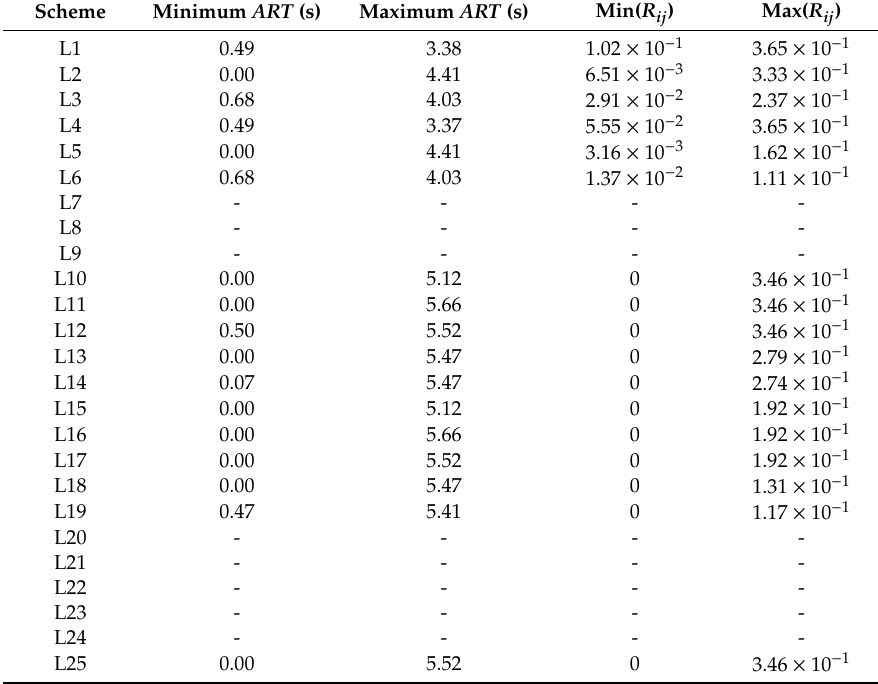
Table 3. Results of the risk analyses: focus on conflict points ( CP s).